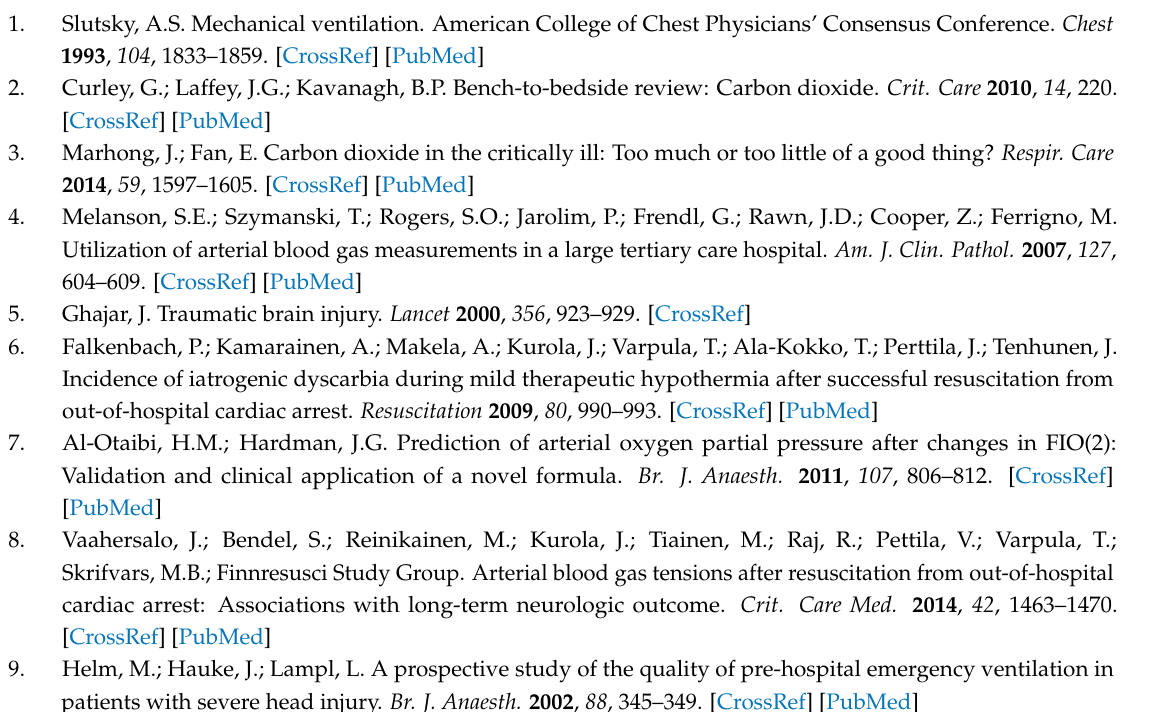
Figure S1: The flowchart of experimental protocol, Figure S2a: The Bland-Altman plot demonstrating the difference between estimated PaCO 2 (Formula 1) and measured PaCO 2 with 95% confidence intervals in animals 9–19, Figure S2b: The Bland-Altman plot demonstrating the difference between estimated PaCO 2 (Formula 2) and measured PaCO 2 with 95% confidence intervals in animals 9–19, Figure S3: The differences between measured PaCO 2 and end-tidal CO 2 values at each time point, Figure S4: The Bland-Altman plot demonstrating the difference between measured PaCO 2 and end-tidal carbon dioxide (ETCO 2 ) with 95% confidence intervals, Figure S5a: The Bland-Altman plot demonstrating the difference between estimated PaCO 2 (Formula 1) and paCO 2 with 95% confidence intervals in 26 cases prior to any intervention aiming at modifying CO 2 , Figure S5b: The Bland-Altman plot demonstrating the difference between end-tidal carbon dioxide (ETCO 2 ) and paCO 2 with 95% confidence intervals in 26 cases prior to any intervention aiming at modifying CO 2 , Table S1: Weight, interventions performed, number of ABG analyses, values of measured PaCO 2 and pH values in the study subjects. The numbering of animals are based on timing, with the first experimental animal labelled number one and the last number nineteen, Table S2: Hemodynamic variables, etCO 2 , etO 2 , PaO 2 and PaO 2 /FiO 2 ratios of each animal during the experiment, Table S3: Estimation of PaO 2 based on values of oxygen-dissociation